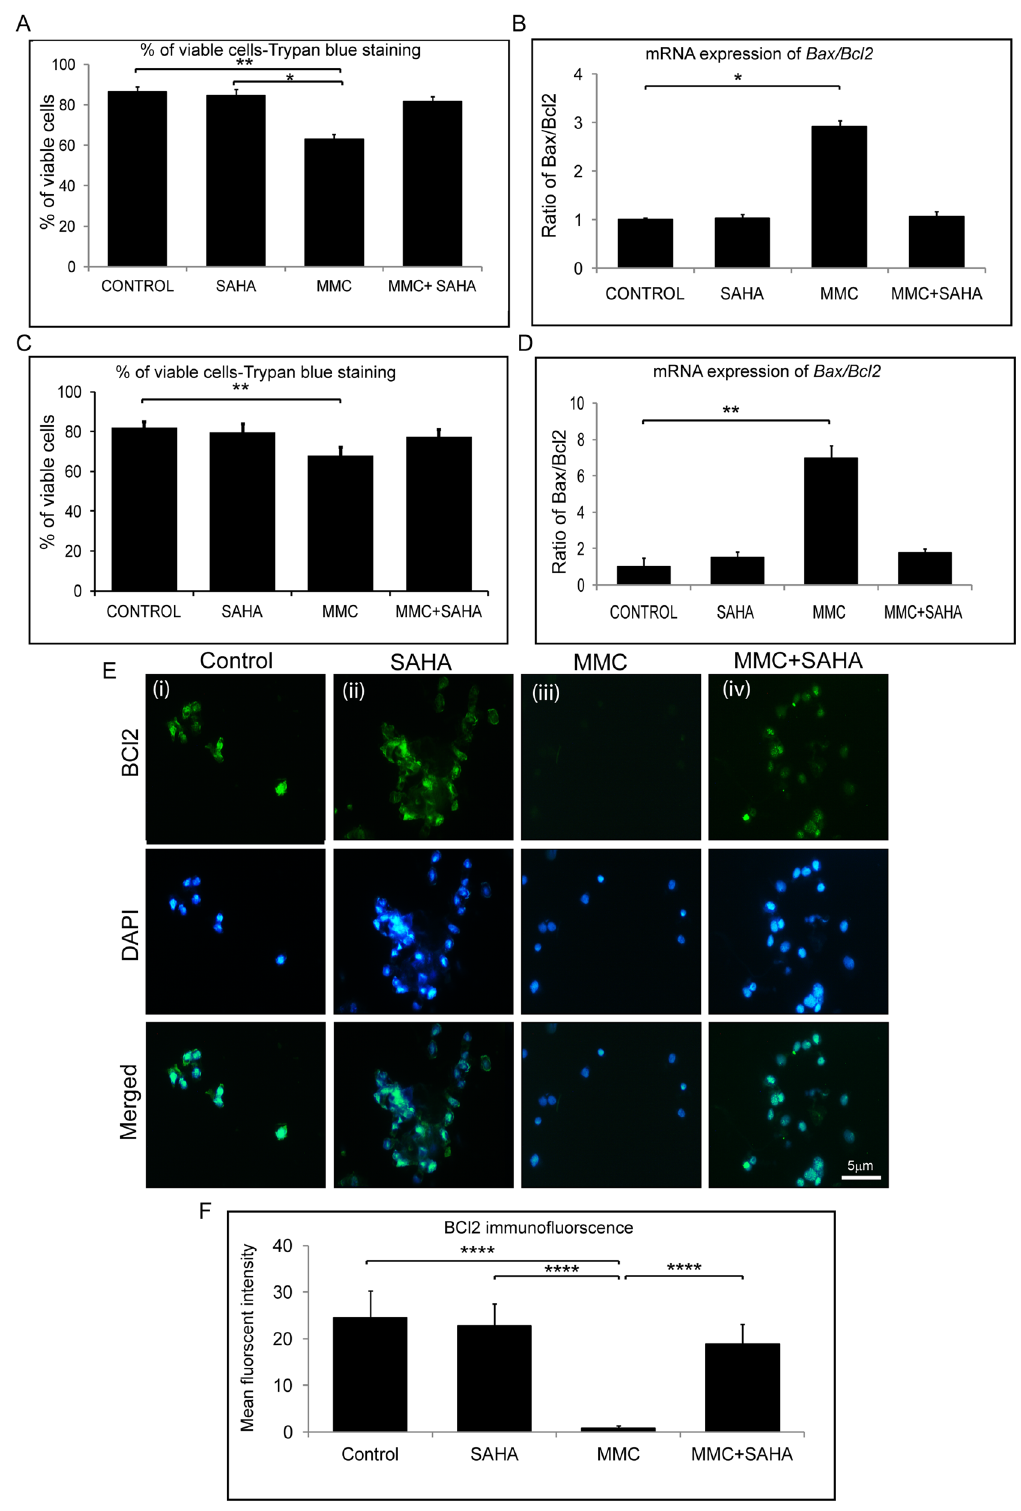
Figure 4. Effect of MMC and SAHA on cell apoptosis levels. Trypan blue cell viability assay results of study group 1 cultures ( A ) and cells from study group 2 ( C ) are represented graphically (n = 4). Ratio of relative mRNA expression of Bax and Bcl2 in treated cells of study group 1 ( B ) and study group 2 ( D ) are depicted (n = 4). Representative immunofluorescence staining images with BCL2 (green) and DAPI (blue) in cells obtained from study group 2 ( E ). For the immunofluorescence staining experiments were conducted (n = 3). In total 200–220 cells were analyzed per treatment group and represented graphically showing the mean fluorescent intensity of the images ( F ). Statistical significance based on one way ANOVA test denoted by *p ≤ 0.05, **p ≤ 0.01, ****p ≤ 0.0001 was calculated in presence of SAHA and MMC in comparison to untreated cultured cells. Images were quantified using Image J 1.48 version software (http://image j.nih.gov/ij/) and statistical analysis performed using statistical software GraphPad PRISM Ver